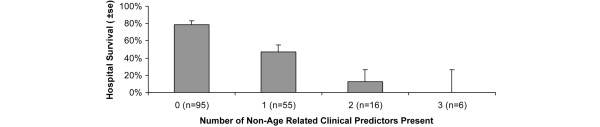
Hospital survival by number of non-age-related clinical predictors identified by multivariate logistic regression analysis. ICU, intensive care unit; se, standard error.